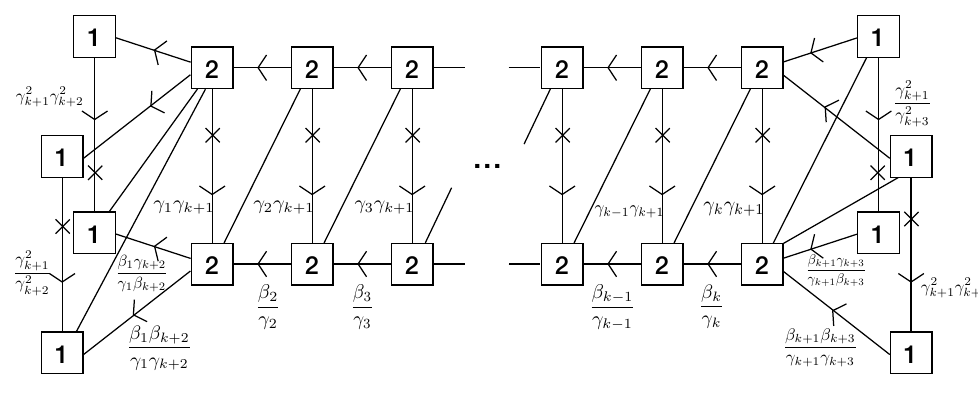
Figure 11 . Basic domain wall for D = f + ; + ; (cid:1) (cid:1) (cid:1) ; + g (cid:13) in the a(cid:14)ne D k +3 quiver